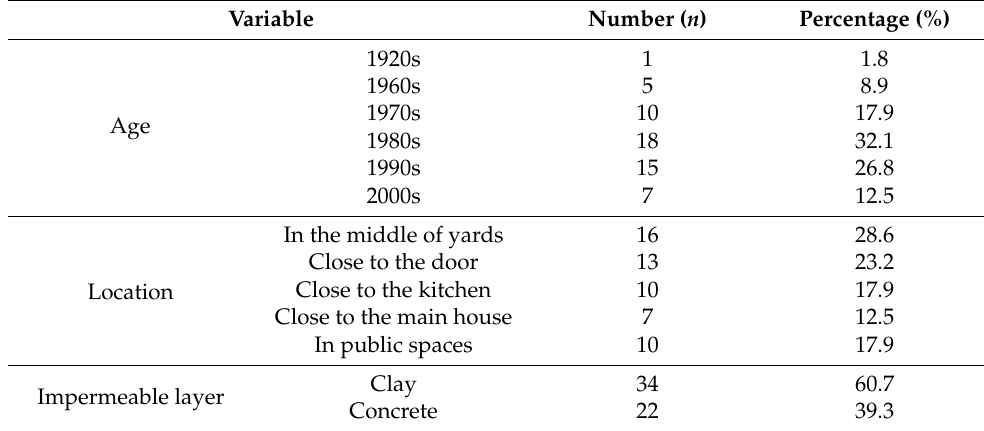
Table 2. Characteristics of target water cellars from each household ( n =